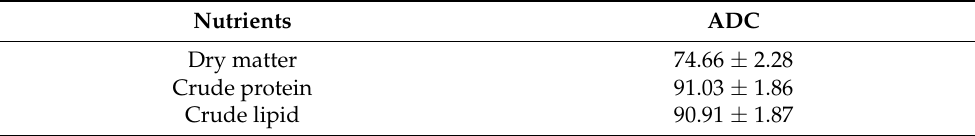
Table 4. ADC (%) in TM of dry matter, crude protein and crude lipid in largemouth